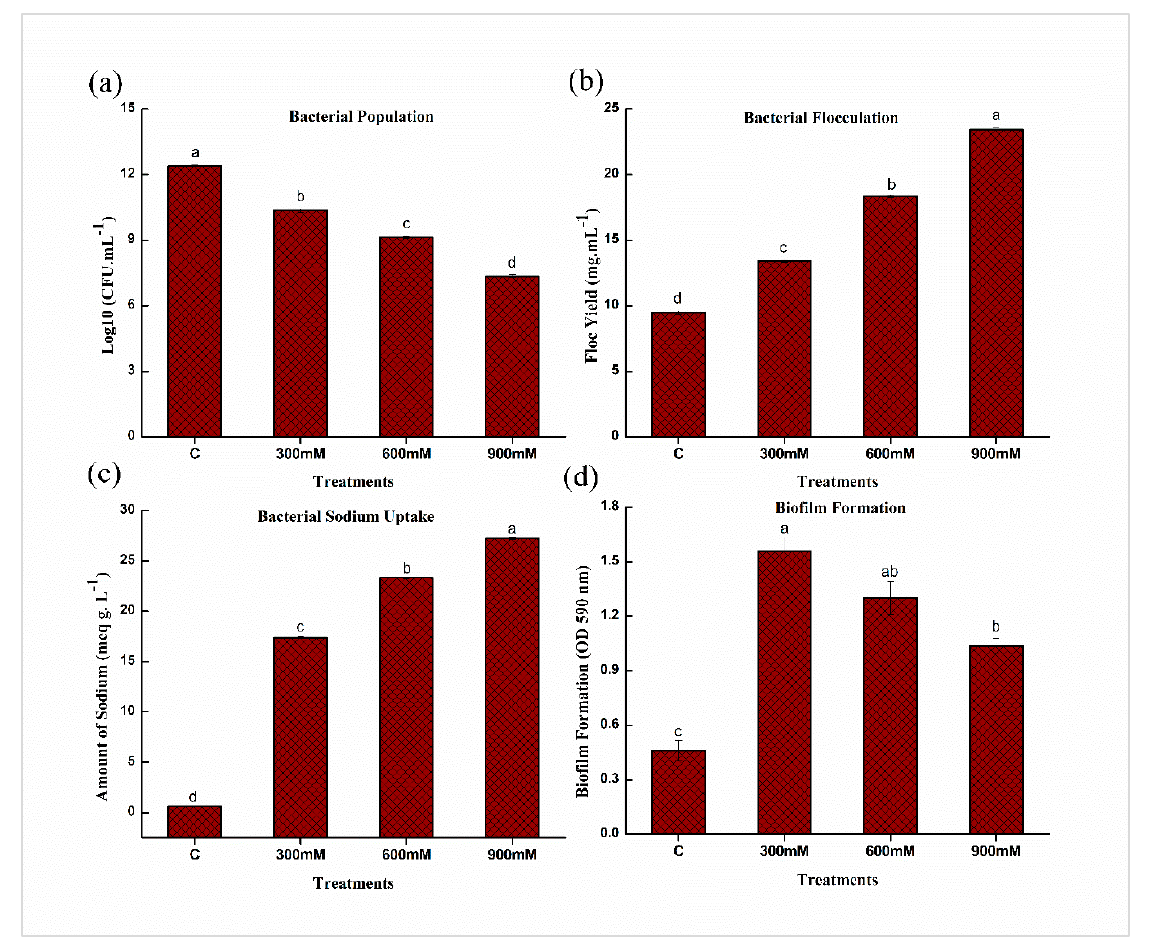
Figure 2. Effects of NaCl on salinity tolerance traits of E. cloacae PM23 ( a ) Bacterial population ( b ) Flocculation yield ( c ) Bacterial Na + uptake ( d ) Biofilm formation. The a, b, c, d inside the figure (on top of the bar graphs) refer to the same meaning in the caption.